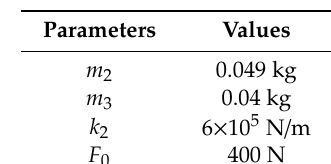
Table 2. The parameters of the system.